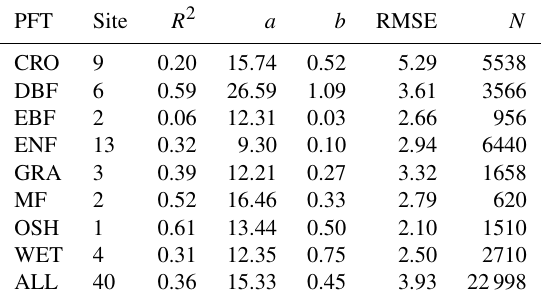
Table 2. Summary statistics of the plant-functional-type-specific GPP and SIF d relationship in eight major PFTs. All pairwise rela- tionships between GPP and SIF d were statistically significant with p < 0 . 0001. a and b denote the fitted parameters from the hyper- bolic model. The unit of RMSE is in gCm − 2 d − 1